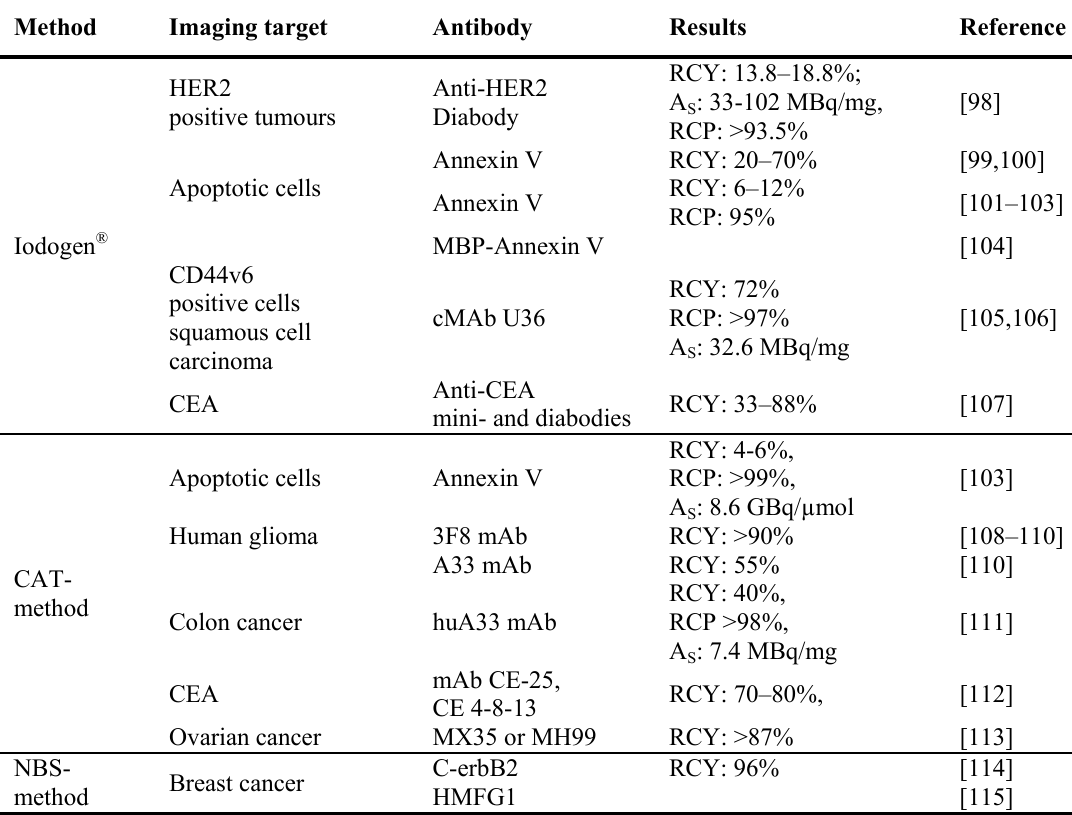
Table 2. Direct labeling of proteins and antibodies with 124